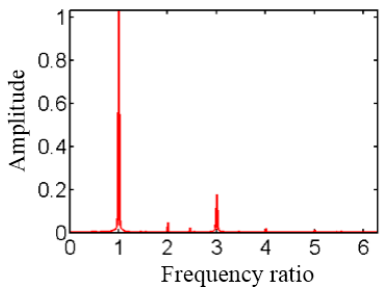
Figure 17. Spectrum diagram of SFD optimized system with the misalignment-rubbing coupling fault.